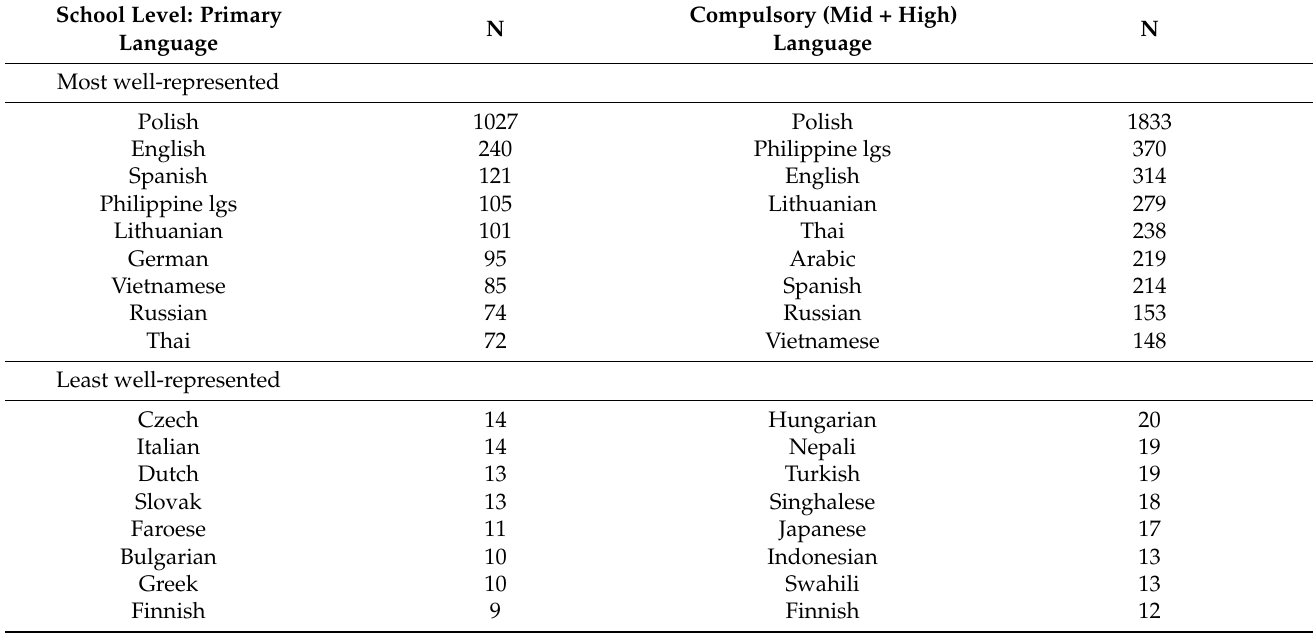
Table 1. Most and least well-represented native languages other than Icelandic in Icelandic schools (pre-schools and compulsory), (Statistics Iceland